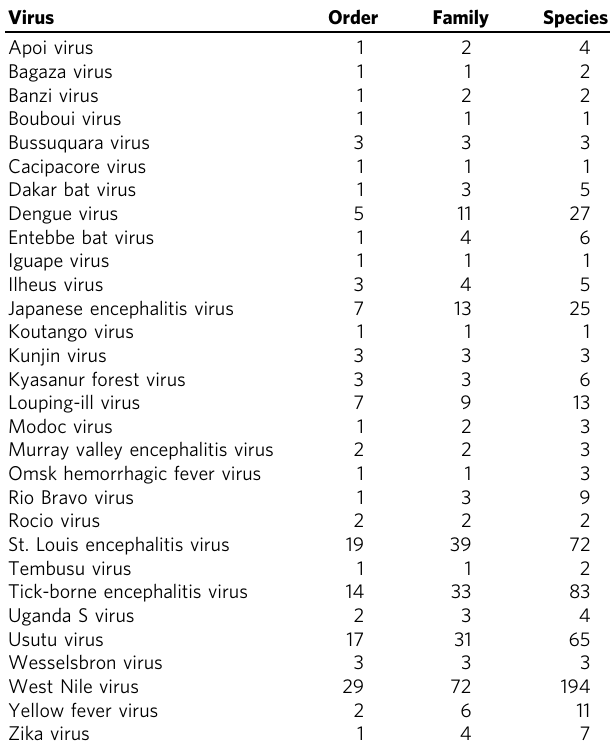
Table 1 Number of known fl avivirus host by virus, classi fi